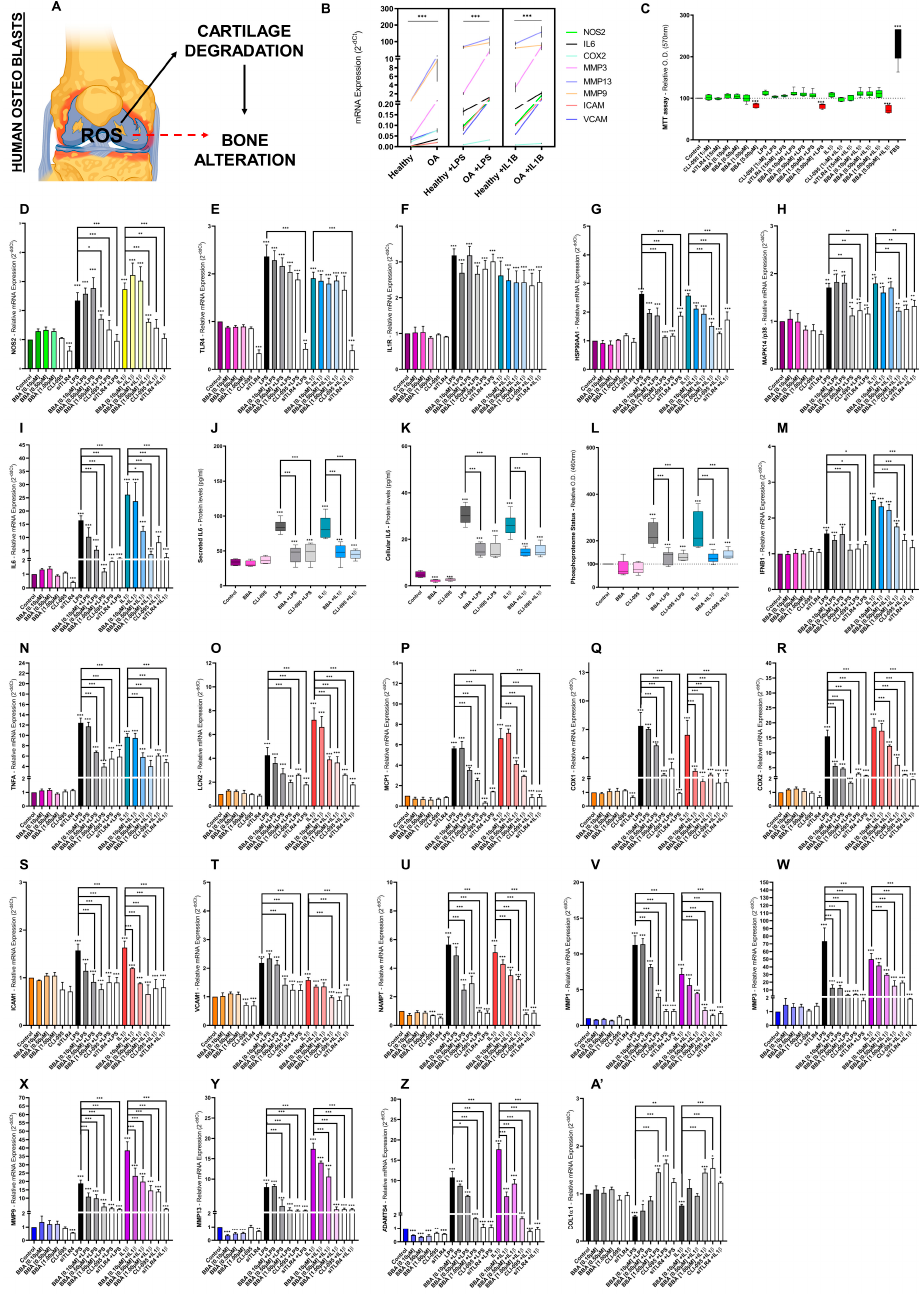
Figure 4. BBA effects on TLR4/IL1R-mediated innate immune response in primary human OA and healthy osteoblasts: ( A ) diagram of the interconnection between articular tissues in osteoarthritis; ( B – A’ ) primary human healthy ( B ) or OA ( B – A’ ) osteoblast (hOB) were treated with BBA (0.10–5 µ M), CLI-095 (1 µ M) or siTLR4 (15 nM) for 24 h and cotreated with LPS (100 ng/mL) or IL1 β (0.1 ng/mL) for another 48 h. Independent biological replicas ( n = 6) were normalized (control), expressed as the mean ± SEM and represented by the statistical significance NEJM system as *** ( p -value < 0.001), ** ( p -value < 0.002), * ( p -value < 0.033); ( C ) MTT cell viability assay in hOB osteoblasts displaying cell inviable doses (red), cell-viable doses (green) and FBS as a positive control; ( B , D – I , M – A’ ) RT-qPCR gene expression (mRNA) of NOS2, TLR4, IL1R1, HSP90AA1, MAPK14/p38, LCN2, COX1, COX2, ICAM1, VCAM1, MCP1, NAMPT, MMP-1, -3, -9, -13, ADAMTS4, and/or COL1A1 in primary human healthy or OA osteoblasts; ( J , K ) ELISA of secreted ( J ) or cellular ( K ) IL6 protein (pg/mL) in primary hOB; ( L ) Green malachite assay (Relative O.D. 460 nm) of phosphoproteome status in primary